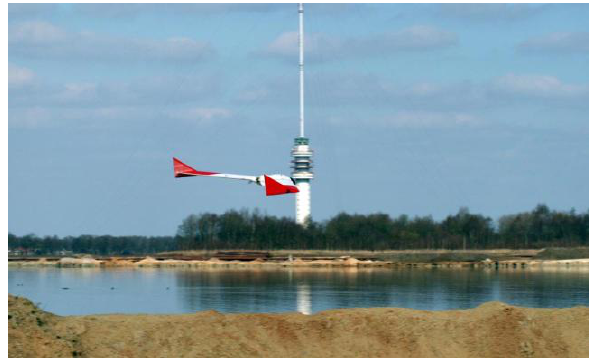
Figure 1 PAMS UAV returning from a mission in